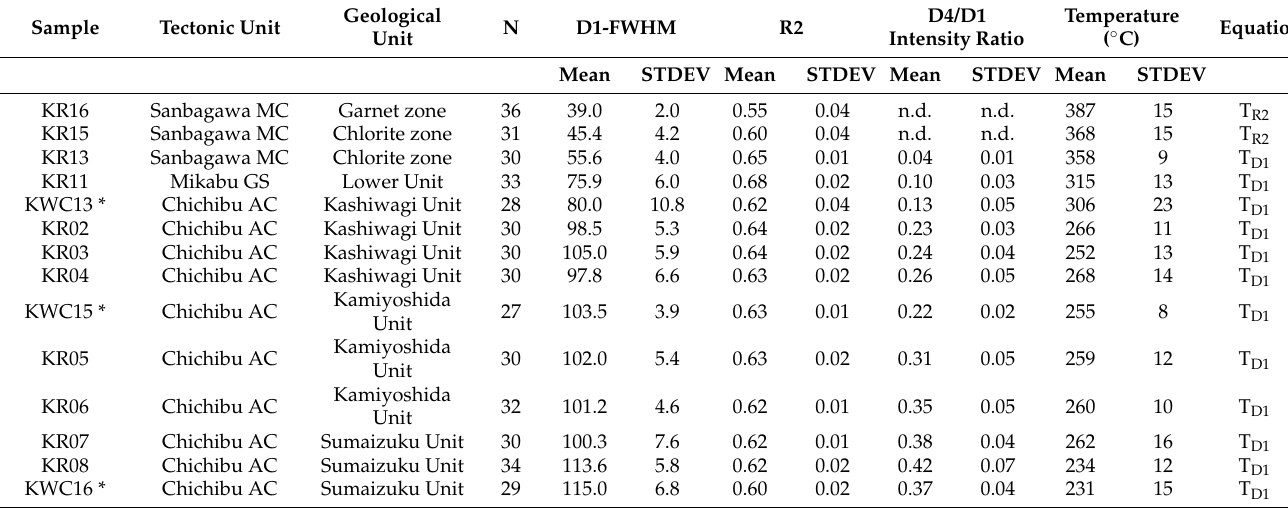
Table 1. Summary of Raman spectral analyses of pelitic rock samples from the study area.